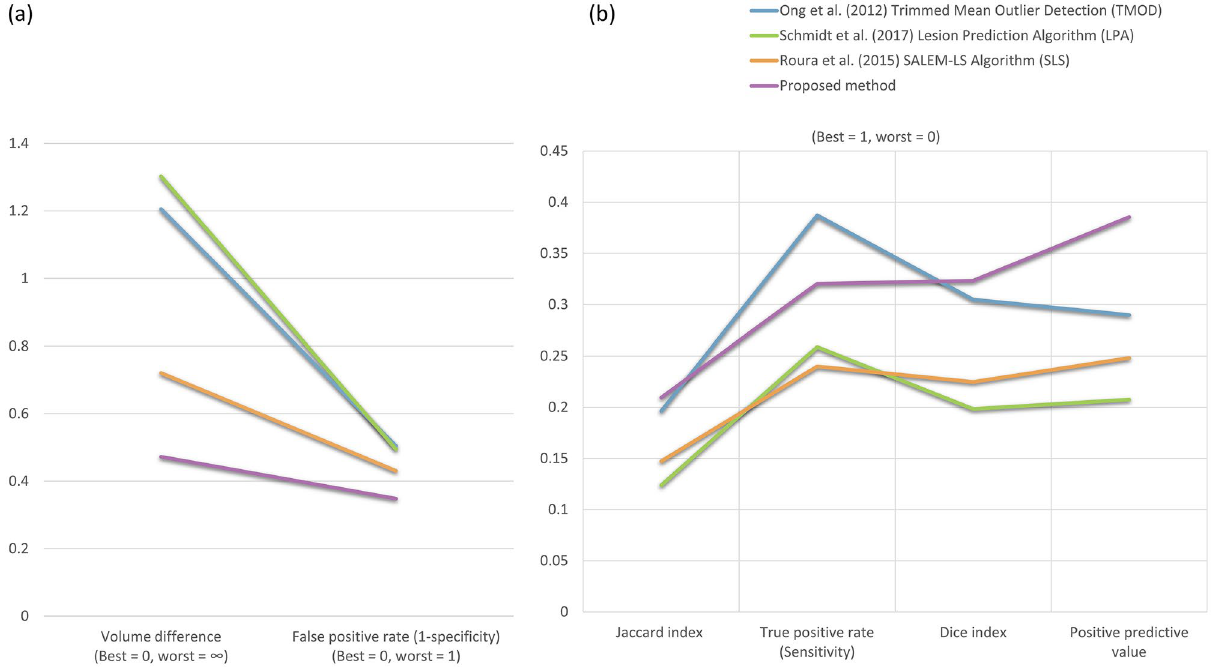
Figure 5. Summaries of all metric evaluations from each automatic method (all 32 subjects). ( a ) Metrics ranging from 0 as the best to 1 or ∞ as the worst performance. ( b ) Metrics with the opposite orientation, where the best performance index is scored 1.0, and the worst performance is